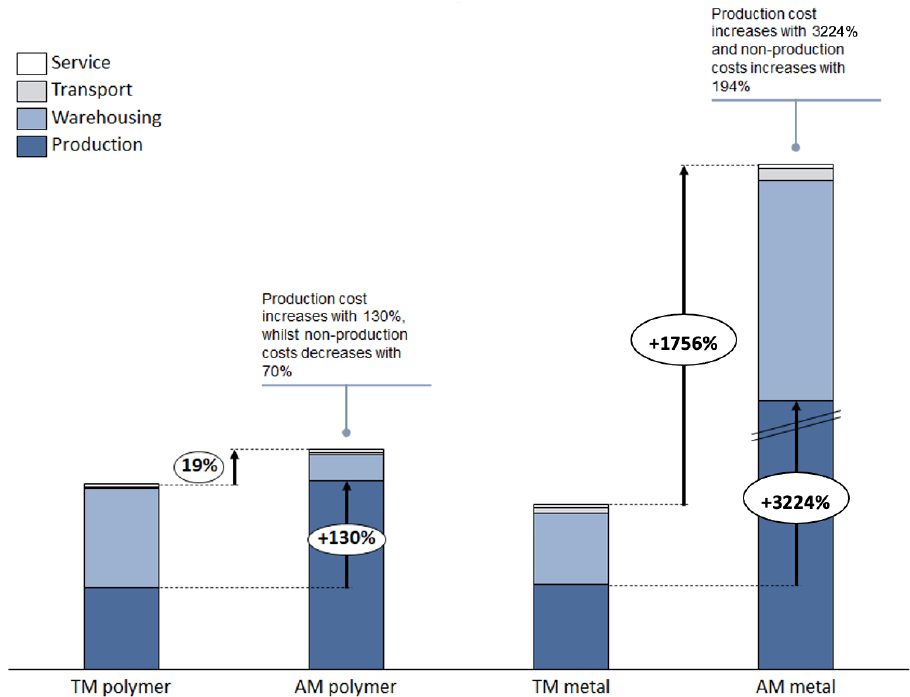
Figure 2. Relative average cost for the four segments.